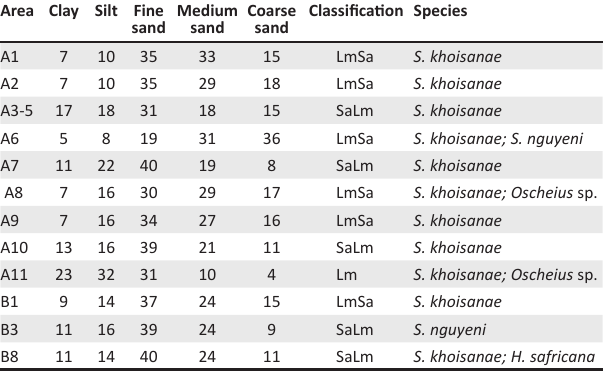
TABLE 2: Representative soil samples analysed using a three-fraction soil analysis to indicate percentages differences in the different sampling regions. Area Clay Silt Fine Medium Coarse Classification Species sand sand sand